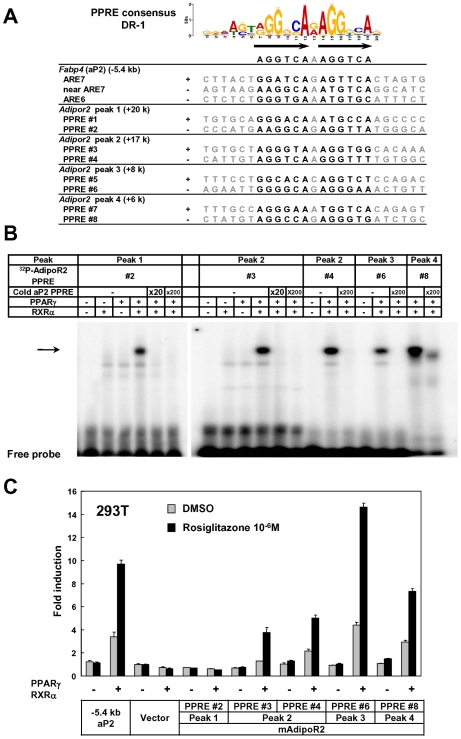
Identification of functional regulatory elements in the intron 1 of Adipor2.The PPARγ binding sites in the Adipor2 gene locus (Figure S2B, arrow heads) were analyzed. (A) Putative DR-1 motifs (PPAR response elements or PPREs) in the regions. ARE6 and ARE7 in the −5.4 kb promoter upstream of Fabp4(aP2) were previously identified PPREs [87]. (B) Gel shift assay showing binding of the PPARγ/RXR heterodimer to the motifs. An arrow indicates the PPARγ/RXRα heterodimer bound by radiolabeled probe. Competition by cold oligos showed the specificity of the binding. (C) Luciferase reporter assay in HEK293T cells. Most of the motifs inserted into reporter vectors with the tk minimal promoter responded to over-expressed PPARγ/RXRα and stimulation with its synthetic ligand, rosiglitazone. The −5.4 kb promoter of PPARγ target gene Fabp4 (aP2) [84] was included as a positive control.